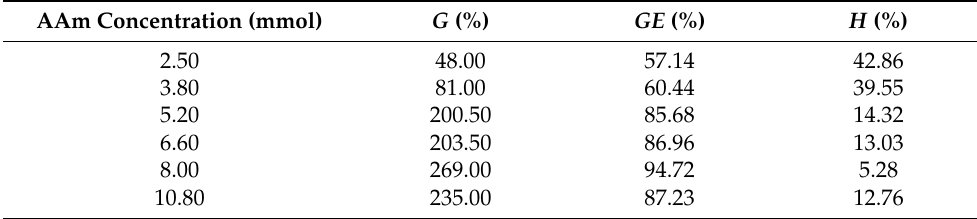
Table 3. Effect of monomer concentration on grafting parameters (power = 750 Watt; t = 100 s; mxan = 0.2 g/L).